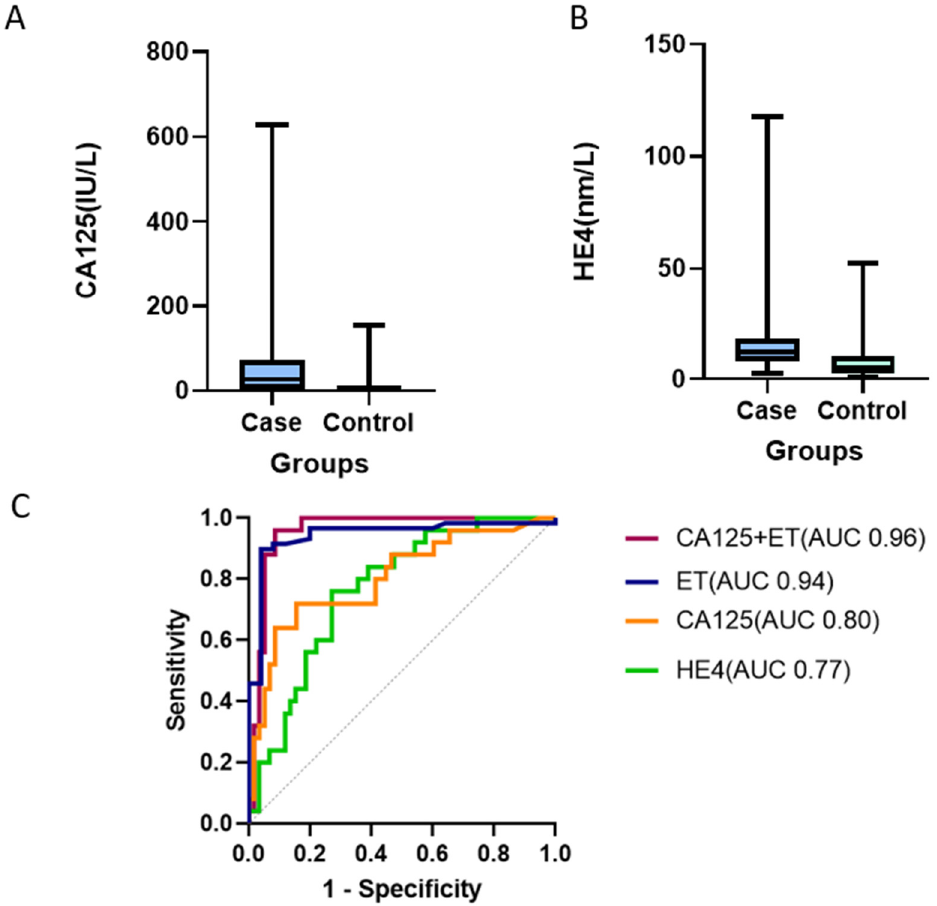
Figure 6. Data validation: boxplots on the distribution of CA125 ( A ) and HE4 ( B ) by cancer status. Receiver characteristic curve analyses indicating the performance of urine CA125, HE4, and the combined CA125 and endometrial thickness model, in the validation cohort ( C ). AUC: Area under the curve.